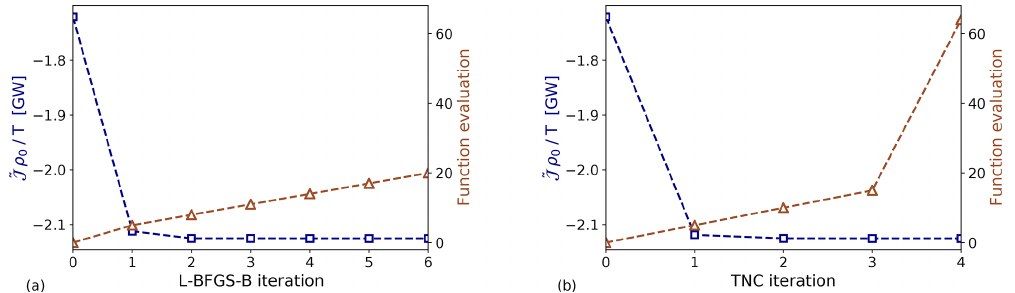
Figure 1. Convergence of the cost functional over the (a) L-BFGS-B and (b) TNC iteration. The squares and triangles denote the cost functional value and the number of function evaluations,